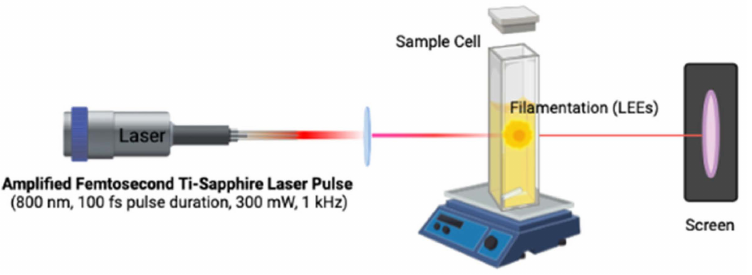
Figure 6. Schematic illustration of an experimental setup to calculate the absorbed dose from a laser pulse using a Fricke dosimeter solution in a sample